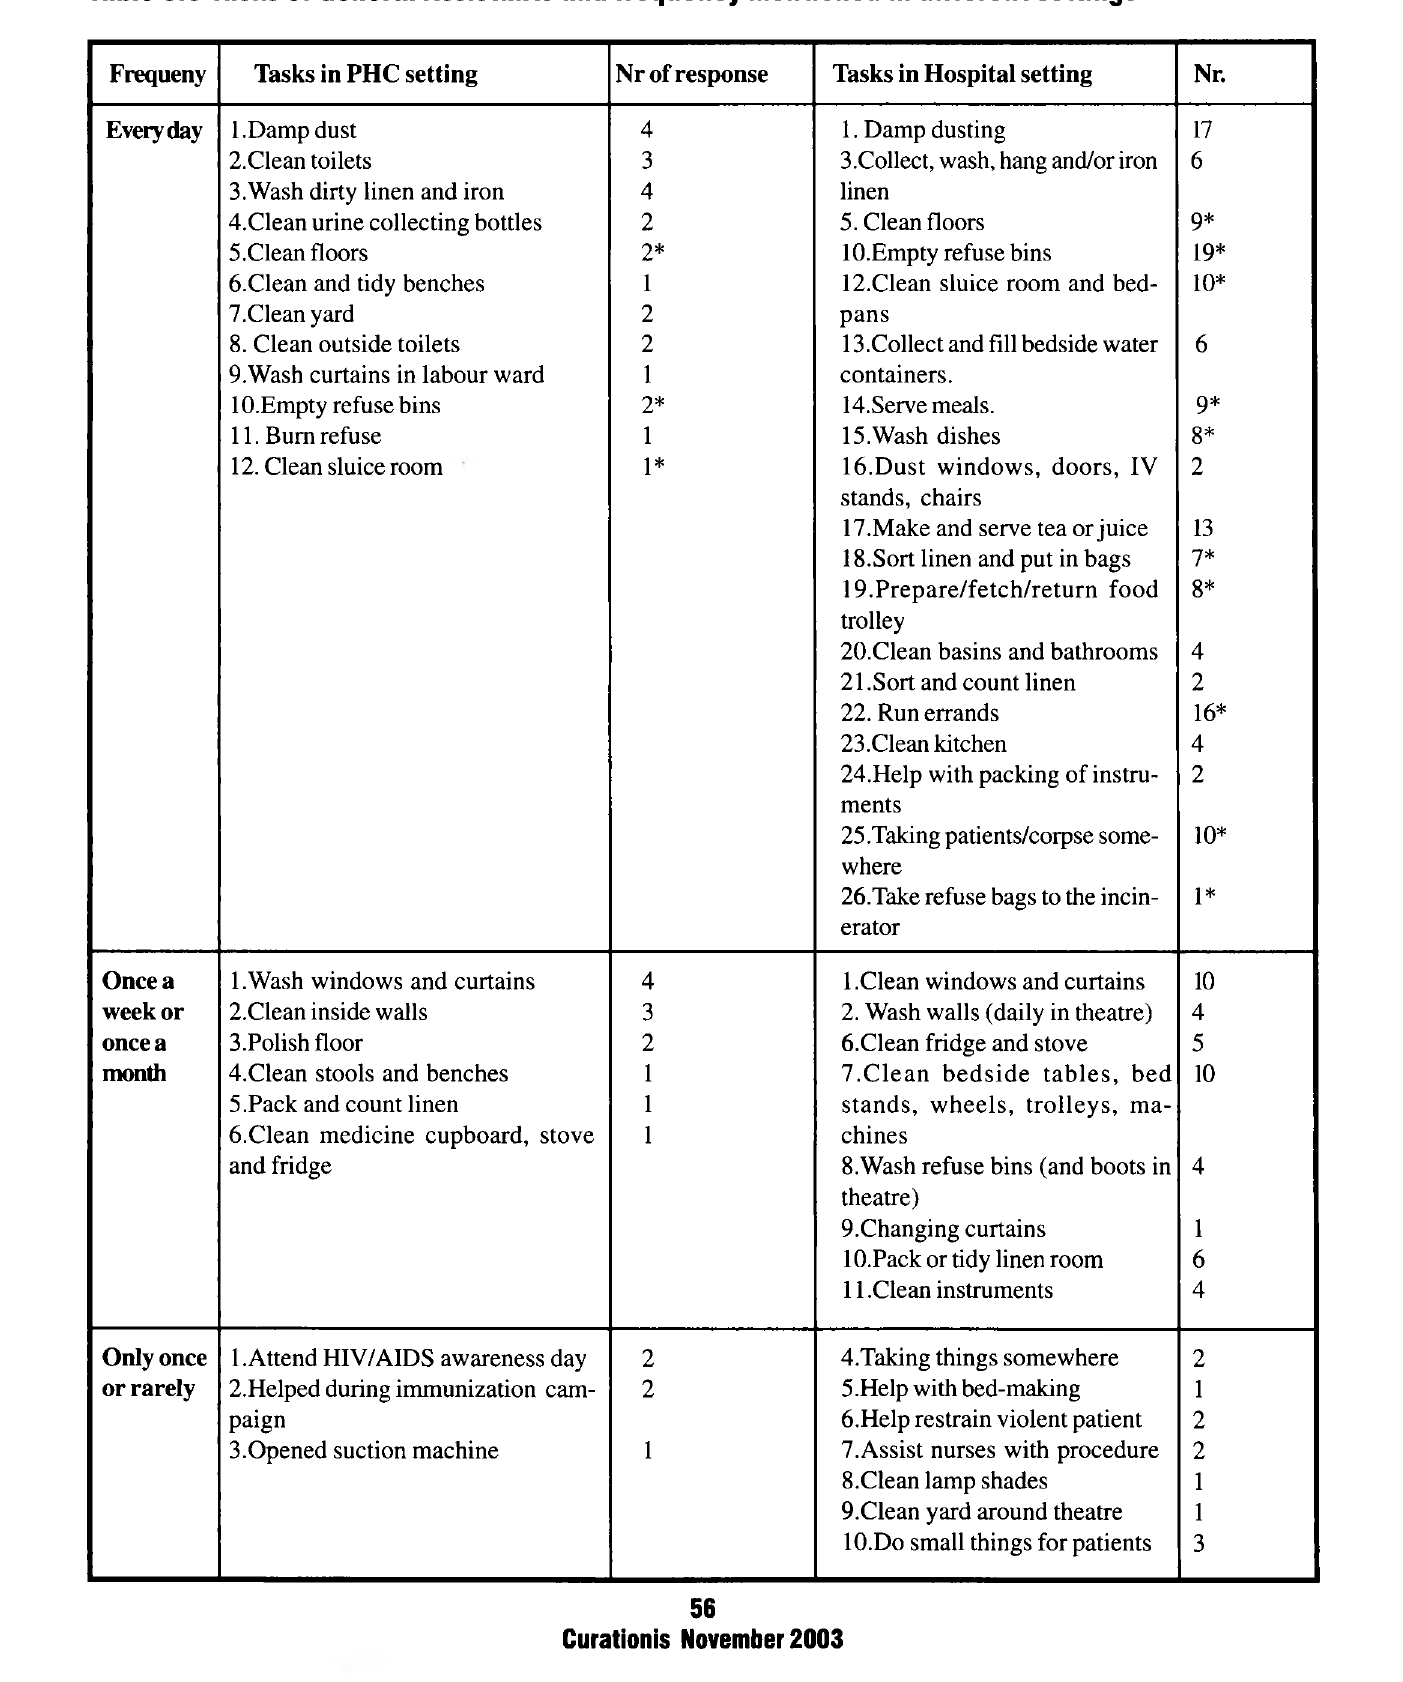
Table 3.3 Tasks of General Assistants and frequency mentioned in different settings Frequeny Tasks in PHC setting Nr of response Tasks in Hospital